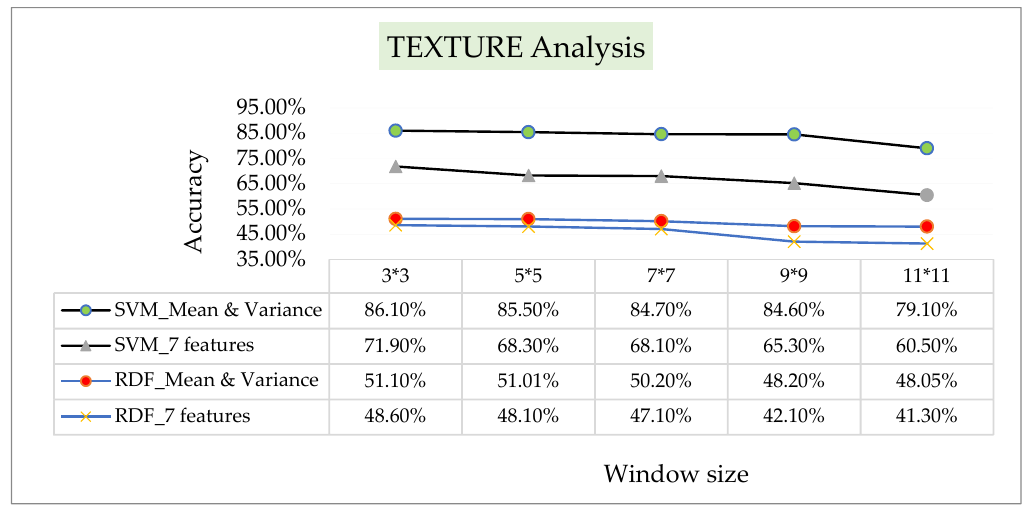
Figure 7. Texture analysis results considering 5 window sizes using RDF and SVM algorithms (3DR).